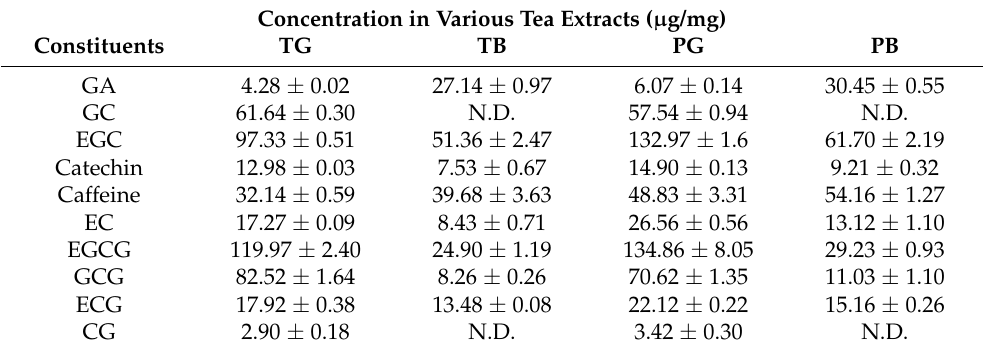
Table 2. Quantitative analysis of diverse types of constituents in various tea extracts. Concentration in Various Tea Extracts ( µ g/mg) Constituents TG TB PG